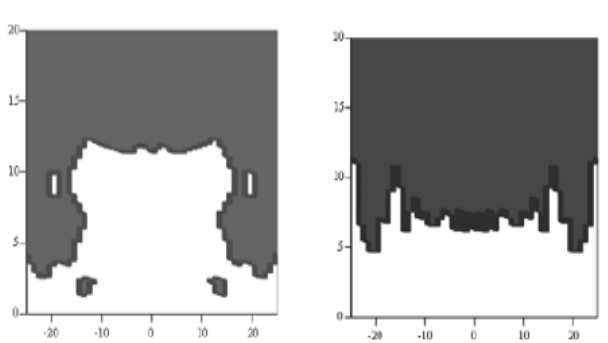
Fig. 5. The boundaries of the change in the processed volume of the oil-water emulsion: using the principle of focused aperture (left), using classical microwave heating